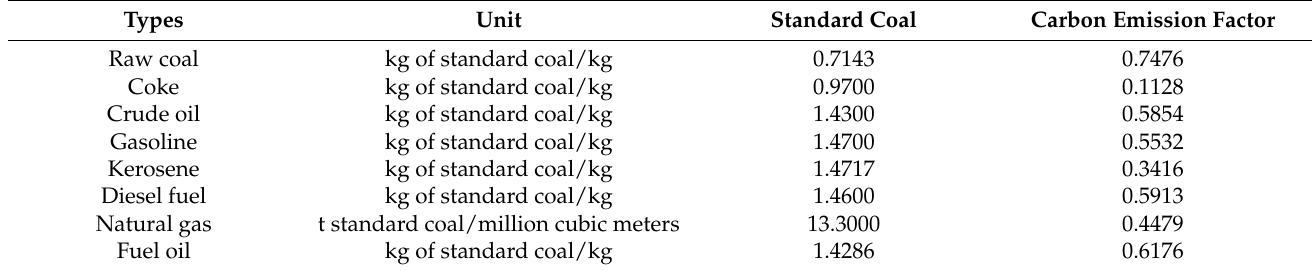
Table 1. Eight types of fossil energy standard coal and carbon emission